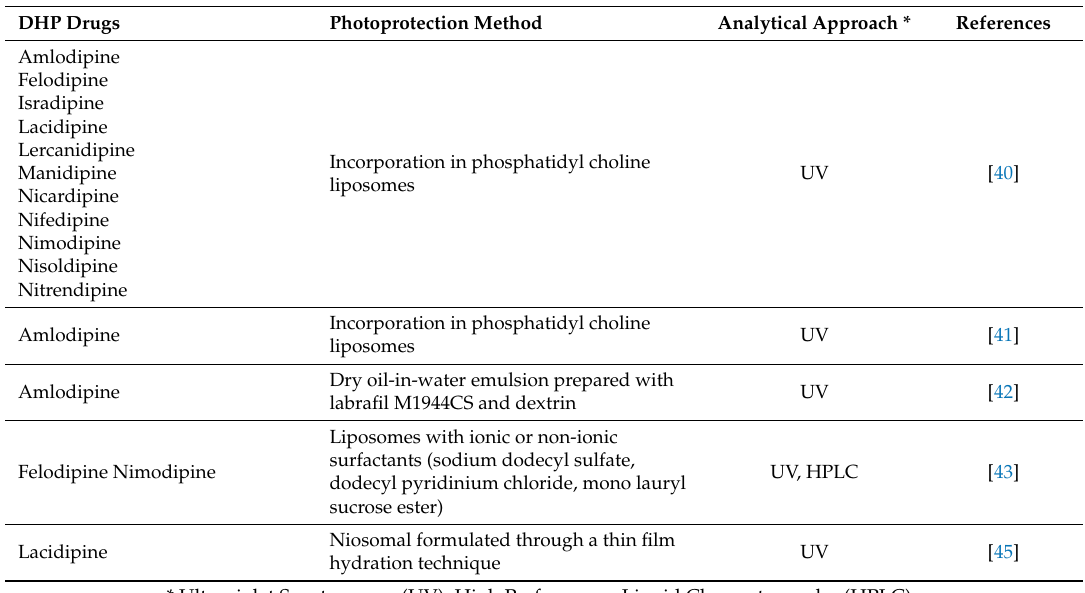
Table 3. Use of liposome